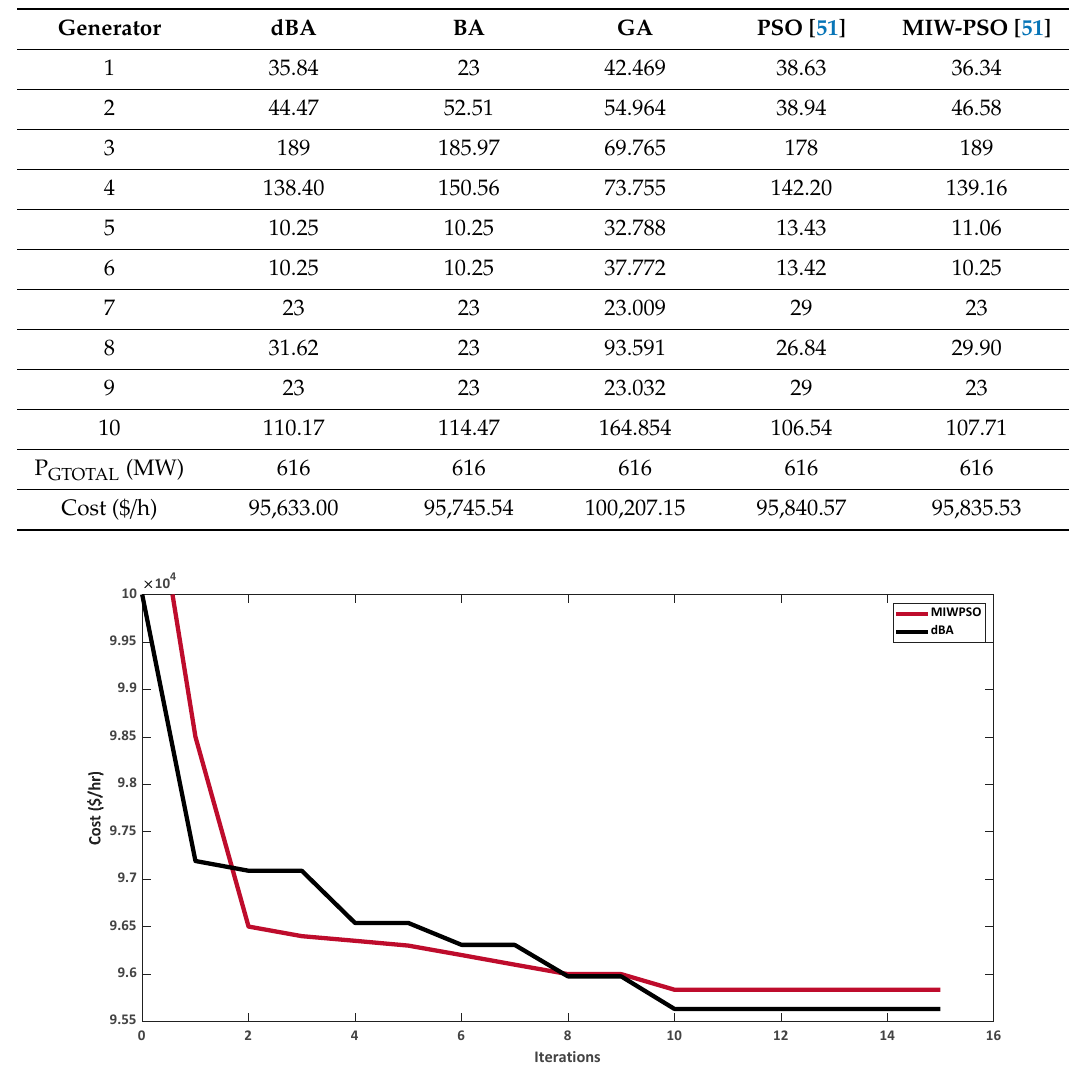
Figure 22. Cost convergence graph of the dBA and MIWPSO in a 10-unit system case.